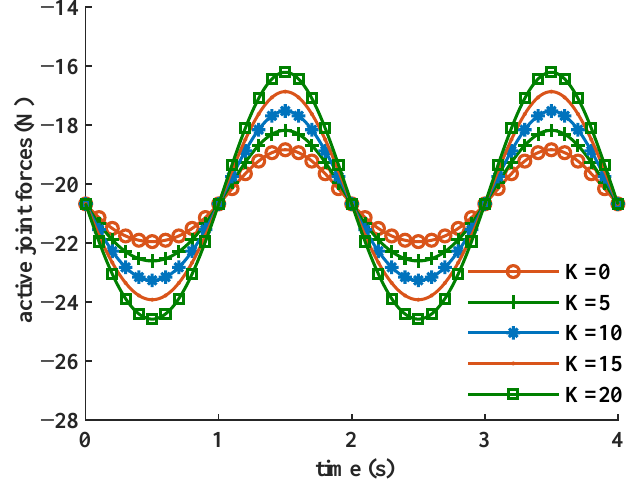
Figure 11. Required active joint forces of the same predetermined trajectory with different flexure stiffness